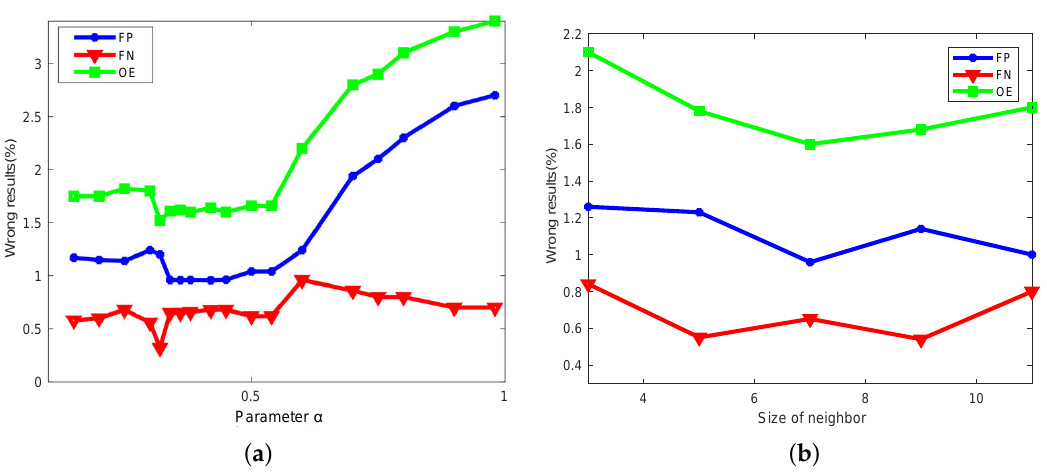
Figure 11. ( a ) Relationship between the size of the neighbor and FP , FN , and OE on the Ottawa dataset. ( b ) Relationship between the parameter α and the criteria on the Ottawa dataset.